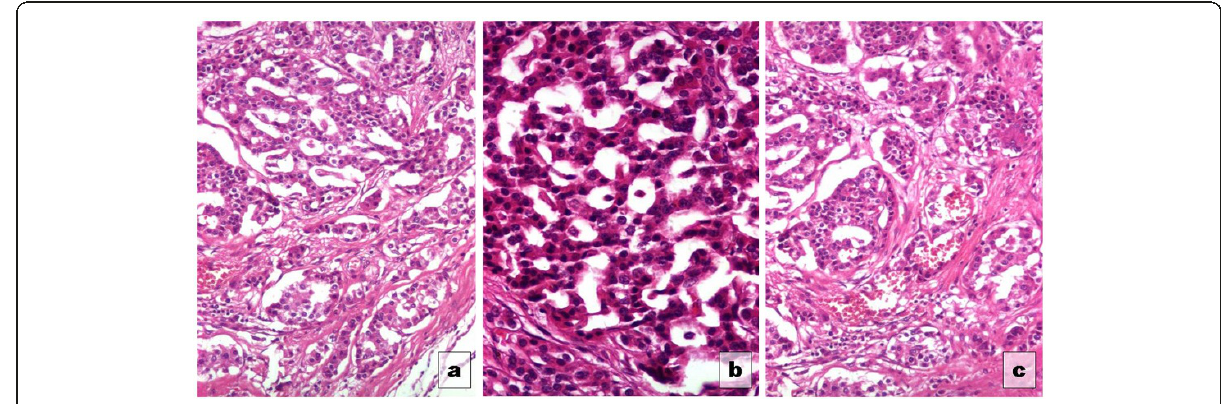
Figure 1 Histological profile of the studied